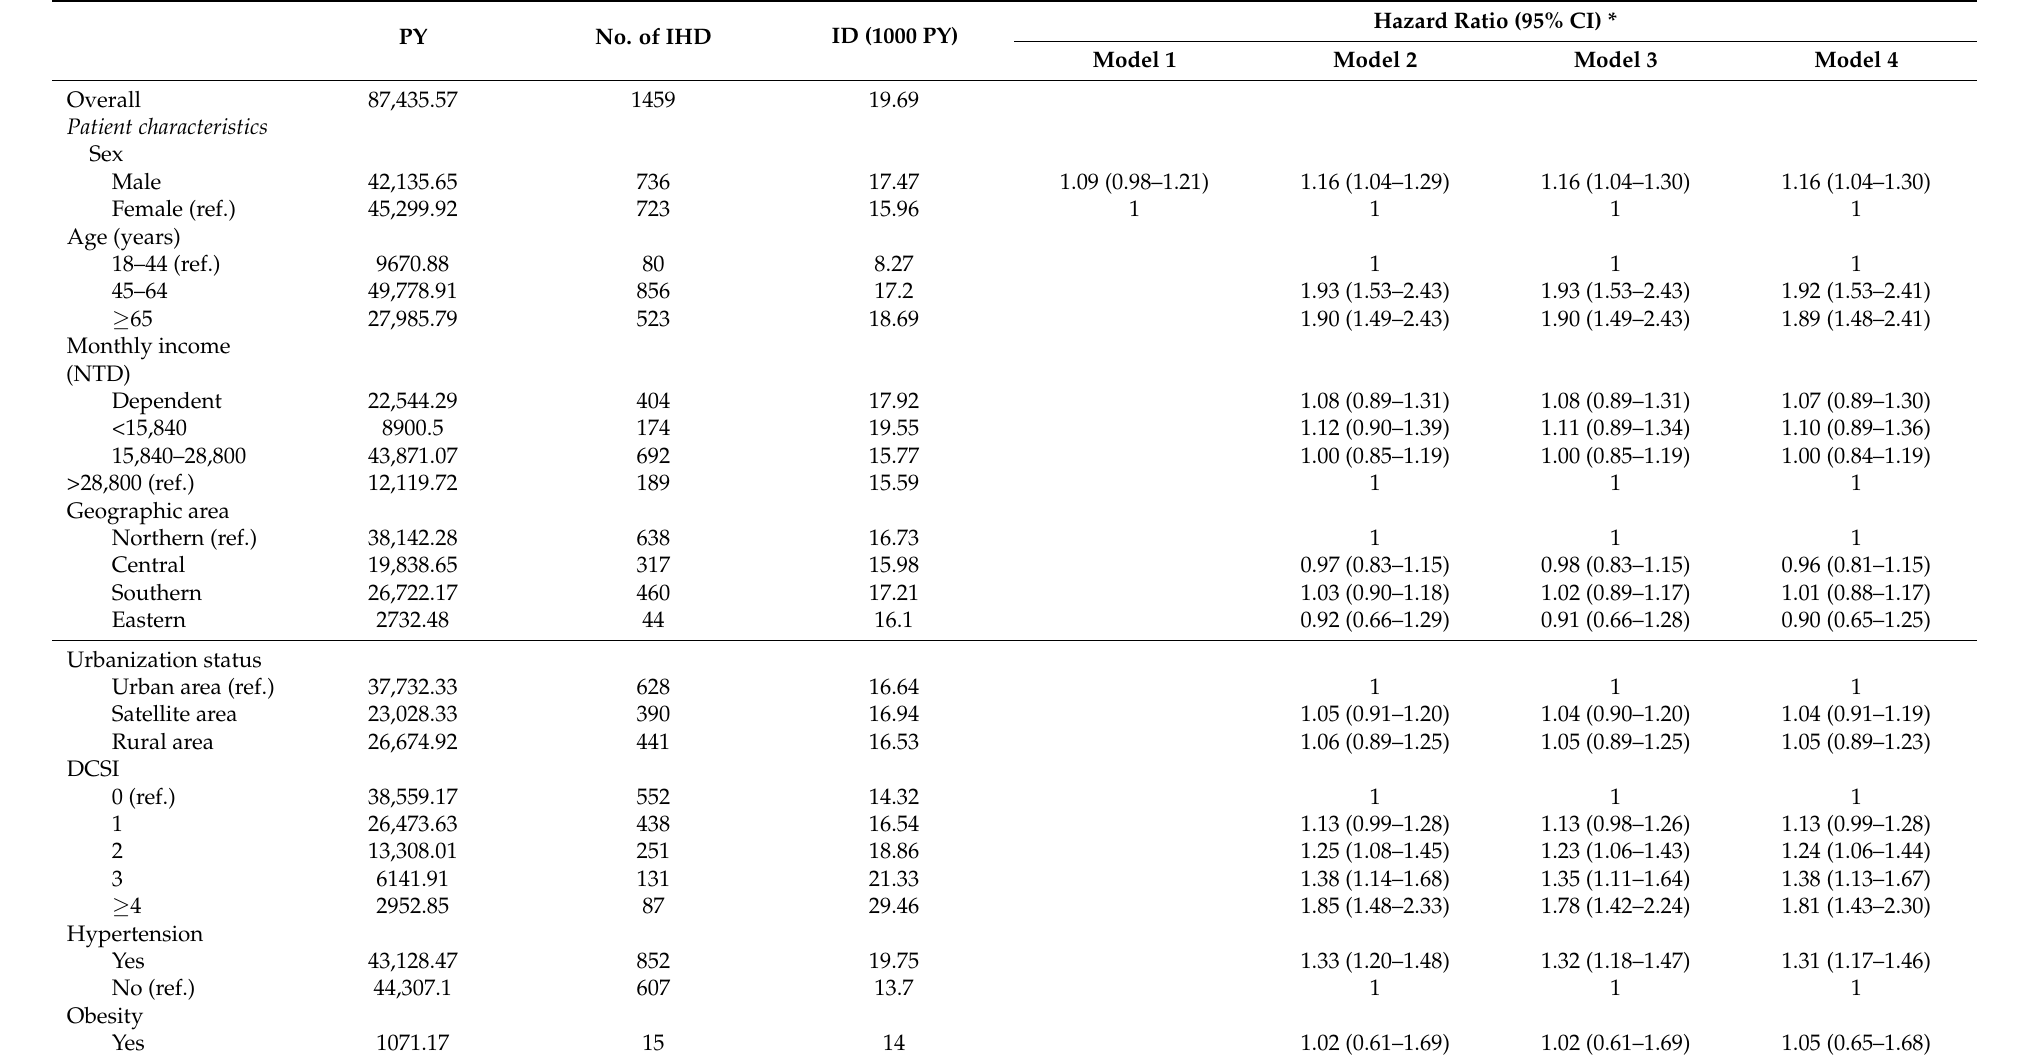
Table 2. Overall and stratified incidence densities and hazard ratios of ischemic heart disease in association with sex and selected covariates among patients with type 2